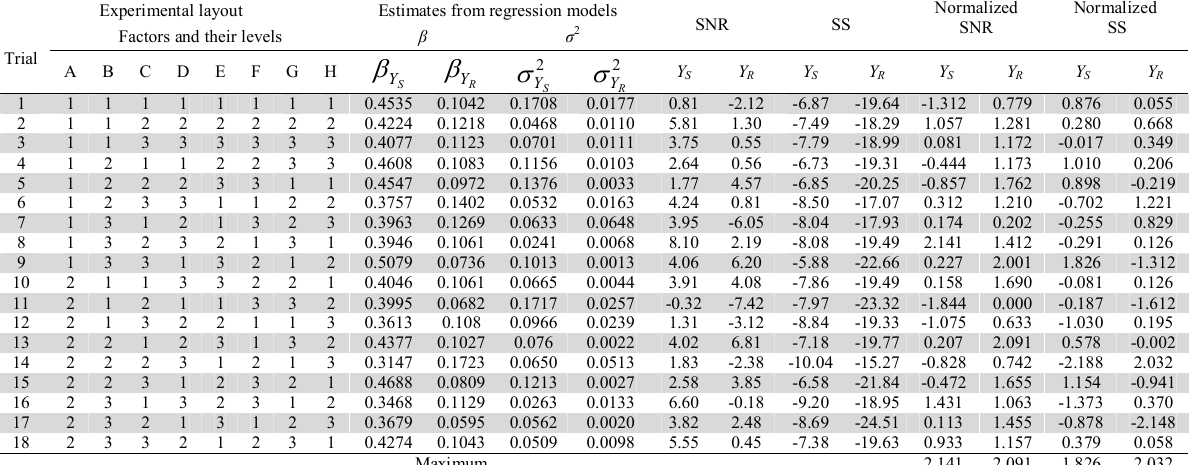
Experimental layout and estimates of β, σ 2 , SNR and SS for the responses (case study 1) Experimental layout Estimates from regression models